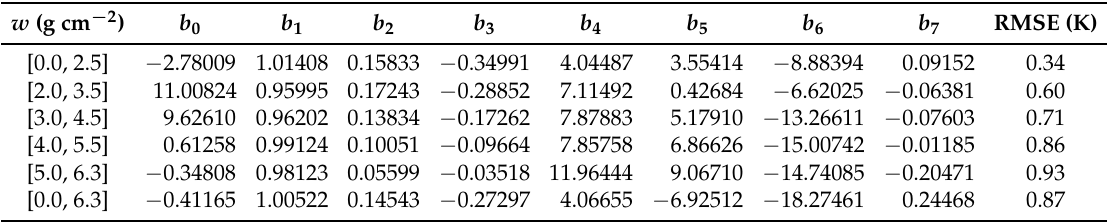
Table 4. Split-Window Algorithm coefficients for Du et al.’s (2015) method as estimated from numerical simulation. Source: Reference